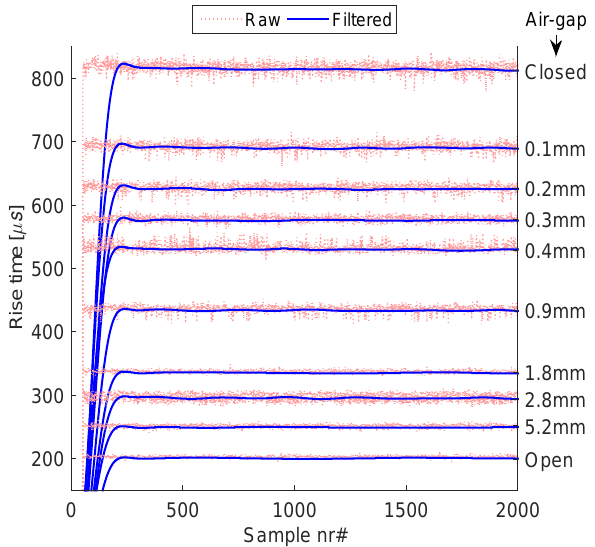
Figure 9. Comparison between raw and filtered rise-time measurements from the CCB taken at ten different air-gaps. Data points were sampled at 300Hz and filtered using a 5Hz filter cut-off frequency.